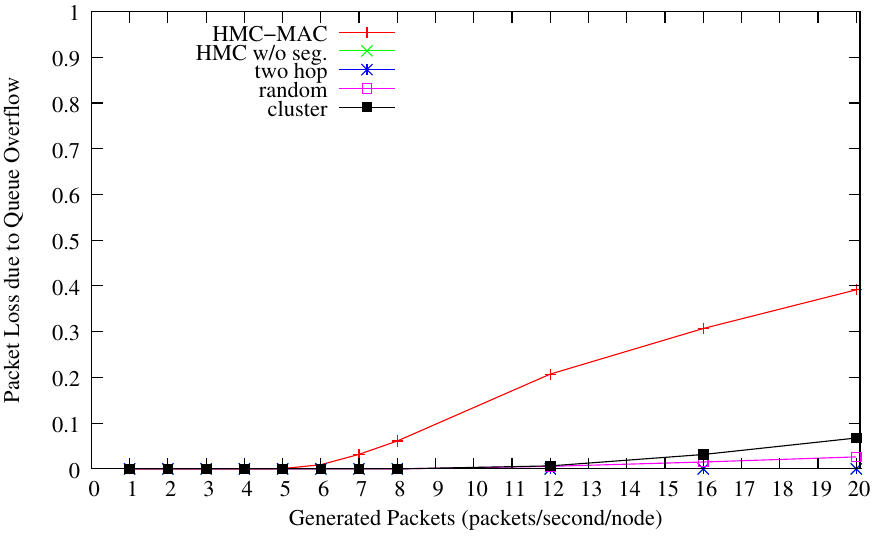
Figure 11. Packet loss due to queue overflow for periodic